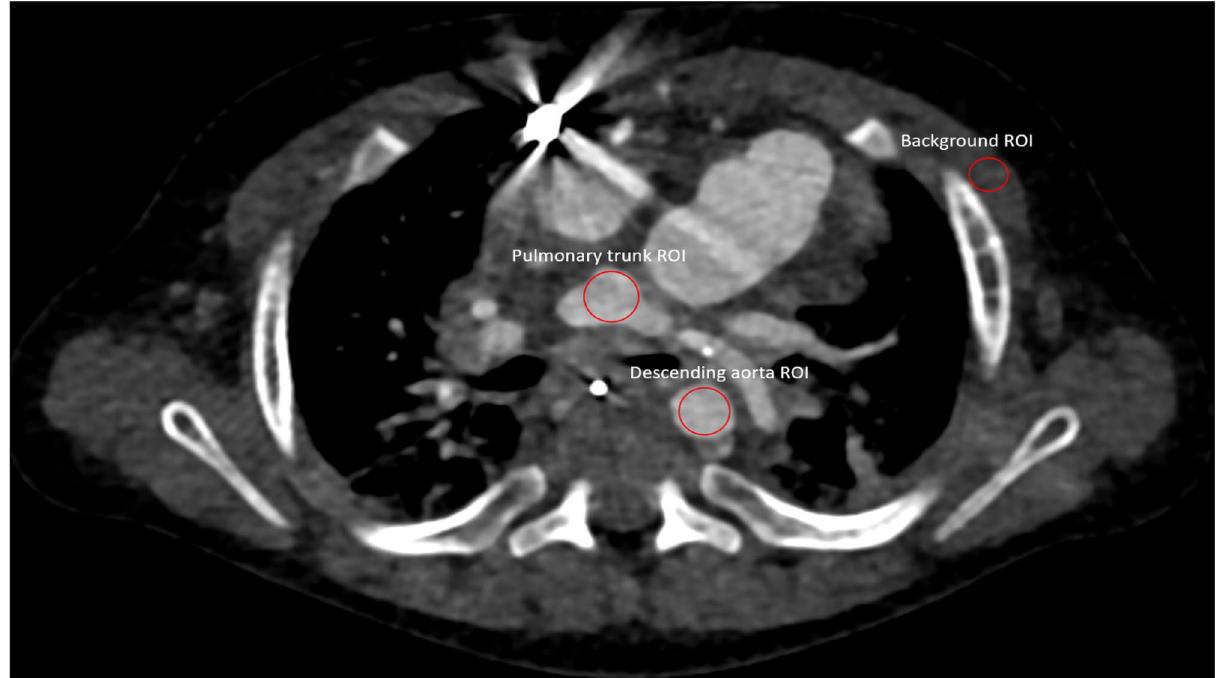
Figure 1. Region of interest (ROI) placement demonstrated in a 7-month-old male patient with hypoplastic left heart syndrome. Due to the varying anatomy of the included patients, ROI size was scaled individually for each patient to include as much reasonably possible without measuring adjacent